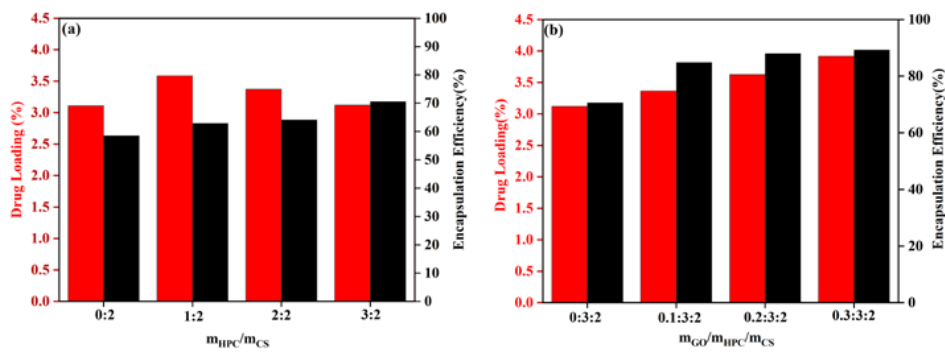
Figure 6. DL and EE of ( a ) HPC/CS@5-Fu and ( b ) GO/HPC/CS@5-Fu.